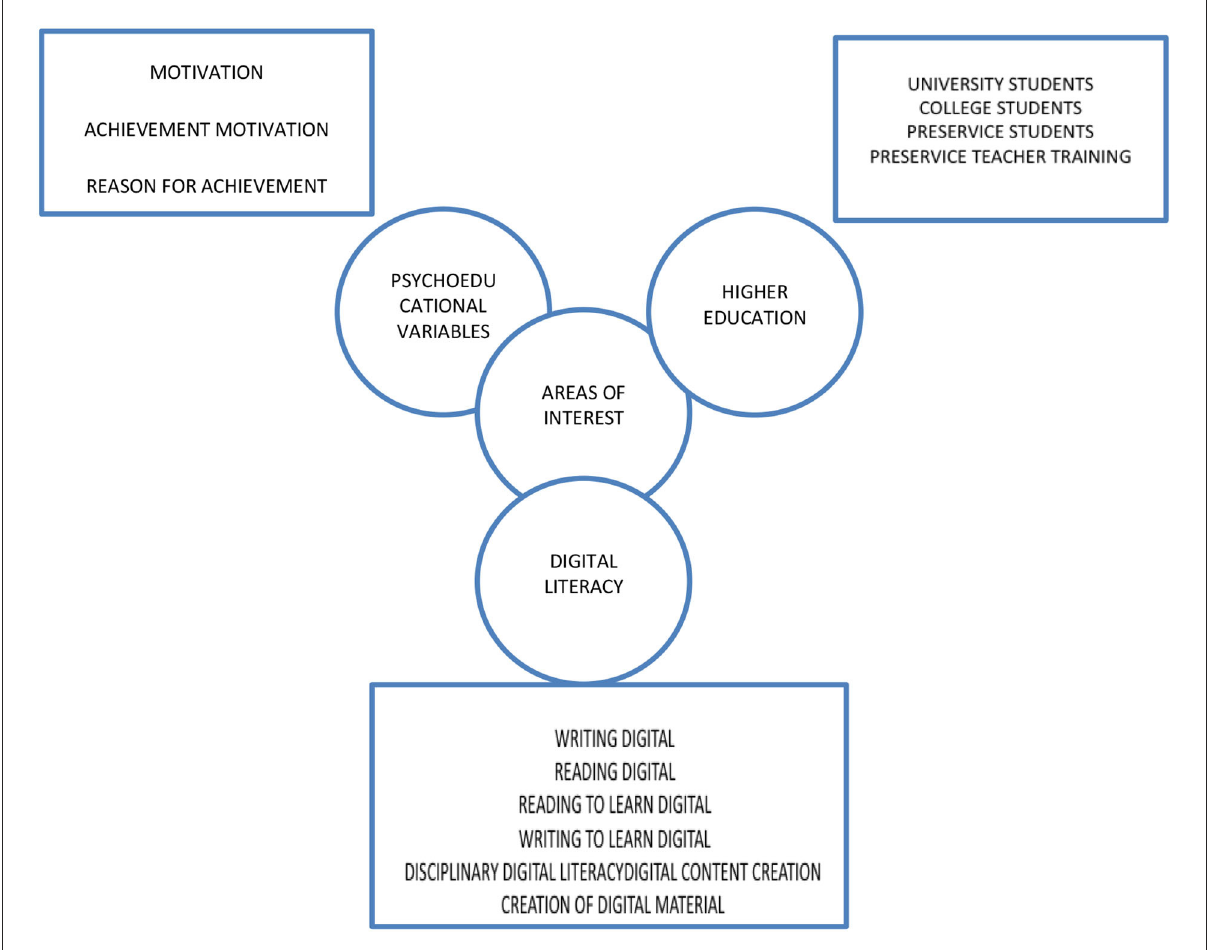
FIGURE1 Diagram of search terms used in the systematic